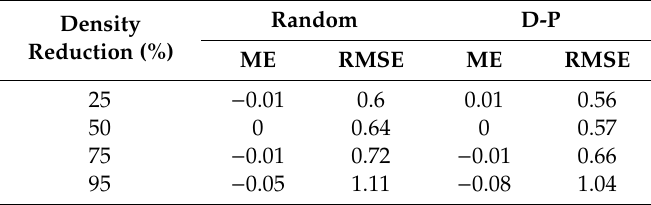
Table 7. Soil ECa map accuracy results, showing ME and RMSE based on external validation for di ff erent density reductions with random selection and Douglas-Peucker algorithms. Random D-P Density Reduction (%) ME RMSE ME RMSE 25 − 0.01 0.6 0.01 0.56 50 0